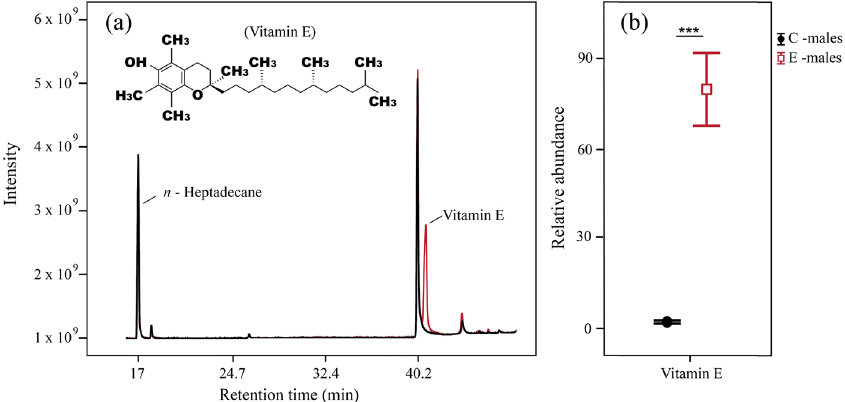
Figure 1. Chromatograms from femoral secretions of Iberolacerta cyreni male lizards. ( a ) Comparison of chromatograms from two different treatments: ‘C-males’ (black) were supplemented with soybean oil, and ‘E-males’ (red) were supplemented with vitamin E. Peaks of interest in this study are the n -heptadecane (internal standard; IS) and vitamin E ( α -tocopherol), which is especially visible in E-males. ( b ) Comparison of the relative abundances (mean ± SE) of vitamin E in secretions of C-males and